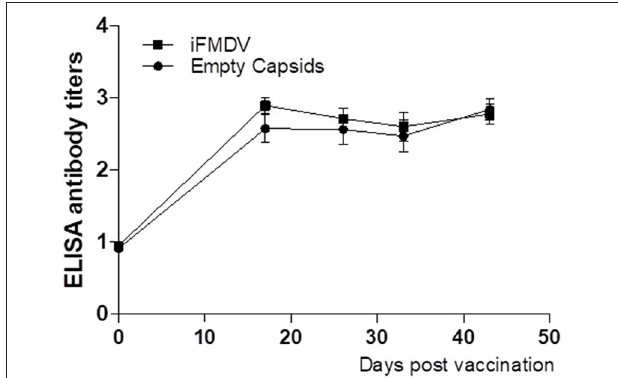
FIGURE 3 | Antibodies titers against FMDV evaluated at 0, 15, 25, 35, and 45 dpv by Liquid phase ELISA in vaccinated cattle. Bovines were inoculated with inactivated FMDV ( (cid:4) ) or empty capsids ( (cid:8) ) formulated with commercial adjuvant. Results are expressed as mean plus SD error bars of 4 animals.